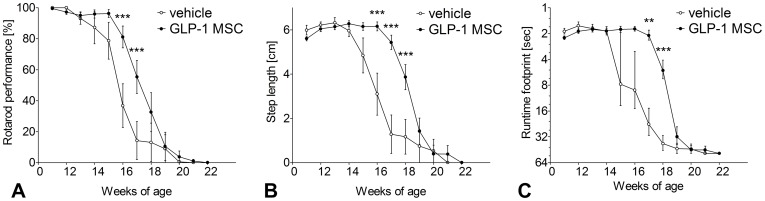
Effects of GLP-1 treatment on rotarod performance and footprint analyses.Presymptomatic GLP-1 treatment (GLP-1 MSC) improved rotarod performance (A), step length (B) and runtime (C) compared to vehicle controls (vehicle). Data are mean ± SEM of 8 (5♀/3♂) (control) and 10 (6♀/4♂) (GLP-1) treated animals. Two-way ANOVA, followed by Bonferroni post-test. (*) p<0.05; (**) p<0.01; (***) p<0.001.